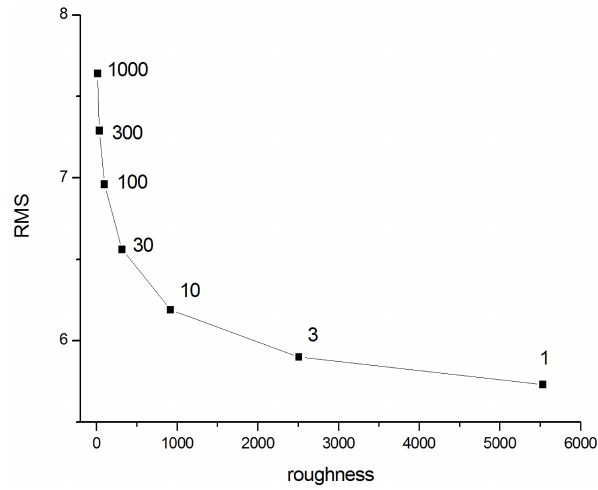
Figure 3. Normalized RMS versus roughness of the models after 30 iterations for different values of the regularization parameter τ